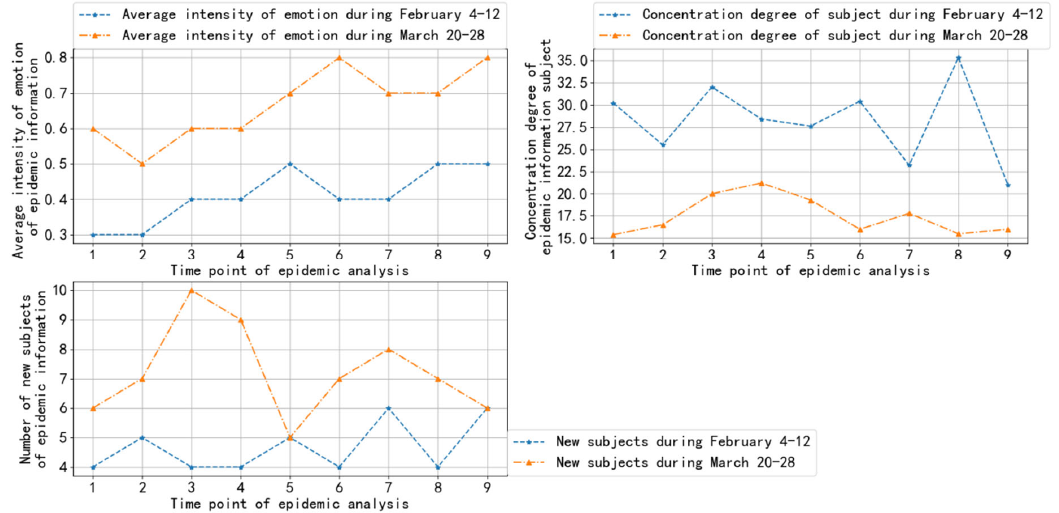
Figure 7. Public opinion indicator value at the micro